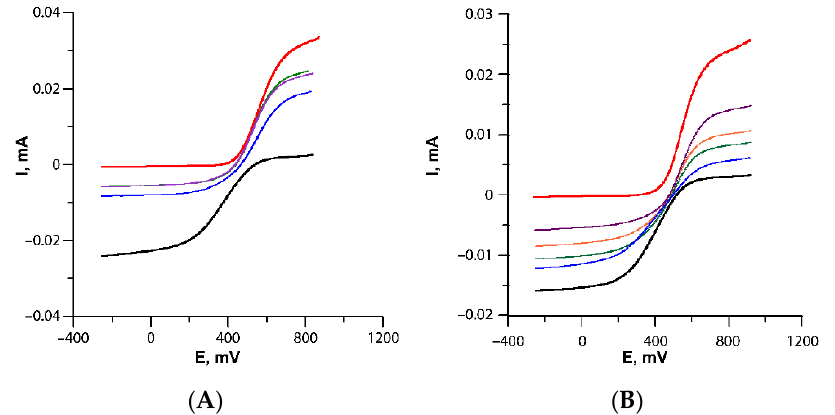
Figure 6. Voltammograms (RDE) of Cu +2 reduction in complex 1 . ( A ) Mixtures of 1 and NAC in a 1:1 ratio registered successively within 25 min after mixing the reagents (blue, violet, and green curves); registered 5 min after mixing of 1 and NAC in a 1:3 ratio (red). ( B ) Mixtures of 1 and ascorbate in a 1:1 ratio registered successively within 100 min after mixing the reagents (blue, orange, green, and violet); registered 40 min after mixing 1 and ascorbate in a 1:3 ratio (red). Black, compound 1 alone.